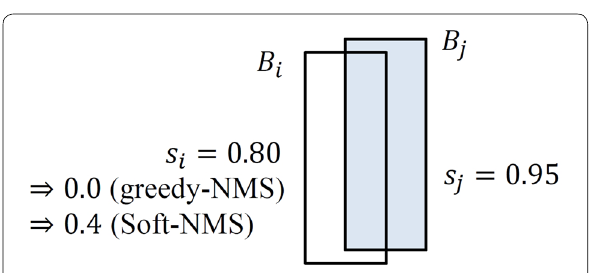
Fig. 9 Difference between the Soft‑NMS and the